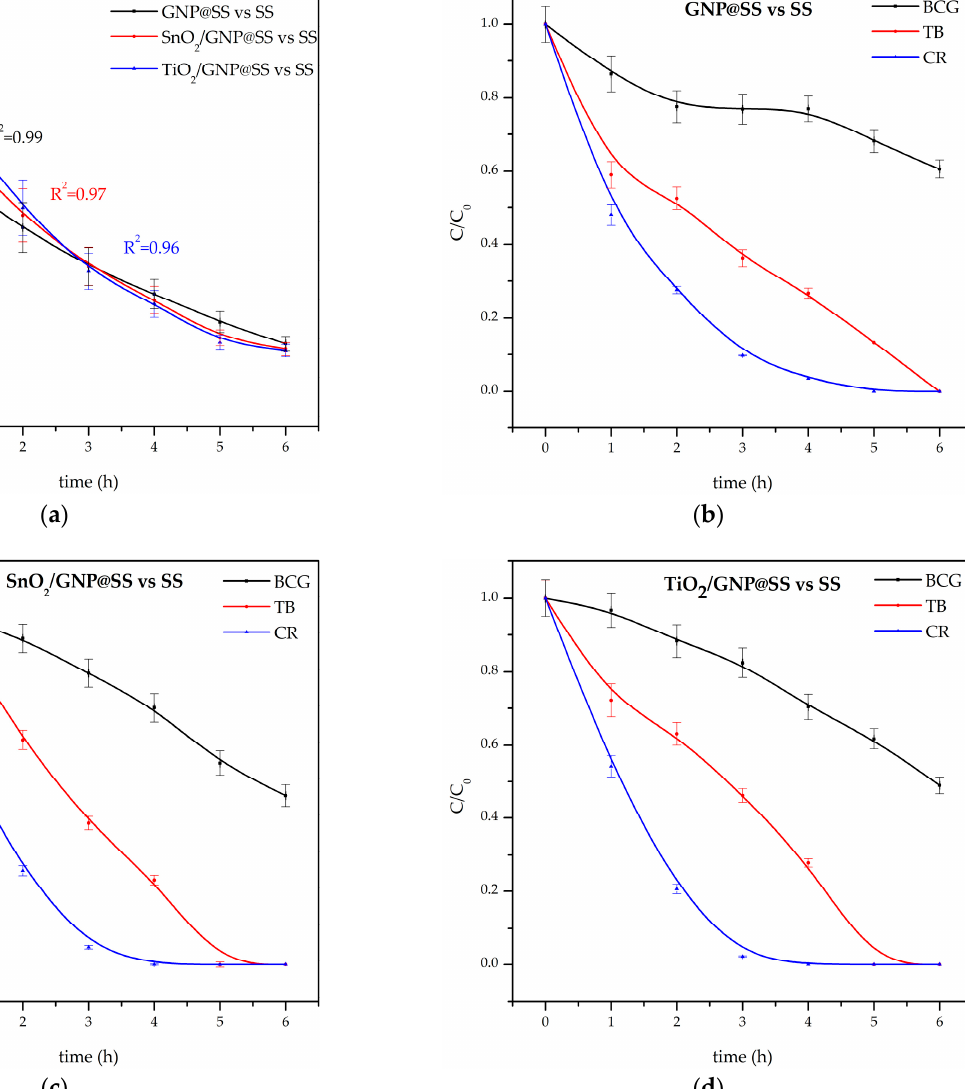
Figure 7. Degradation of dyes mixture (15 ppm dyes mixture in 0.1 M Na 2 SO 4 , mass ratio BCG:CR:TB = 1:1:1) at 10 mA/cm 2 : ( a ) total dyes depletion at all investigated